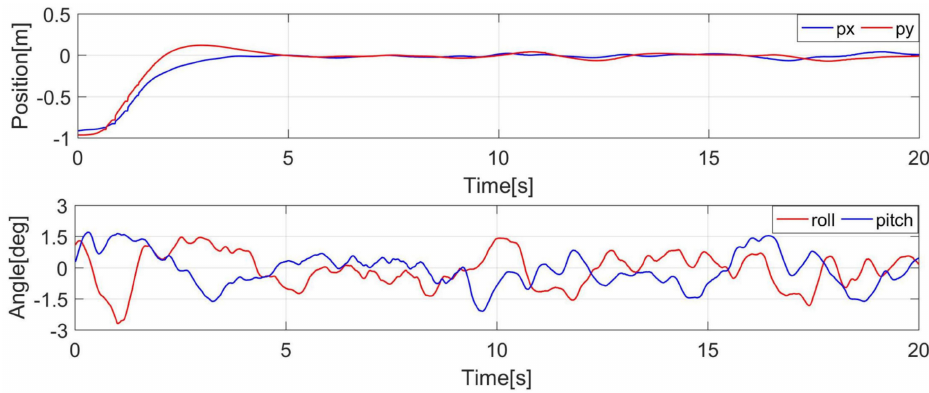
Figure 9. Experimental result of position